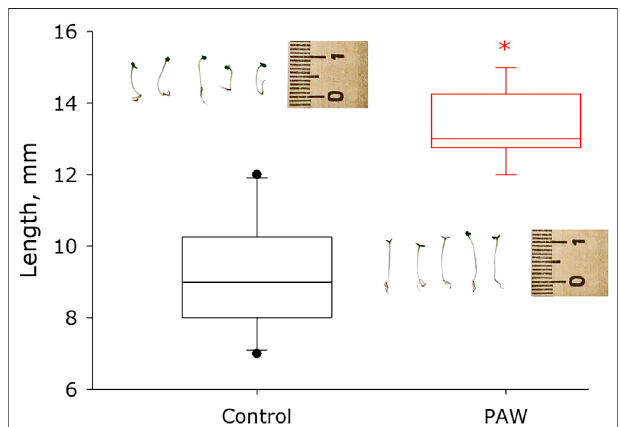
FIGURE 11 | In fl uence of plasma activated water solution on germination and development of seeds of garden strawberry. Data are presented as median with 95% con fi dence interval (box). The range is shown in the form of a whiskers. Statistically signi fi cant differences between s ontrol group and PAW groups (Mann-Whitney U test, p < 0.05) are marked by asterisks.